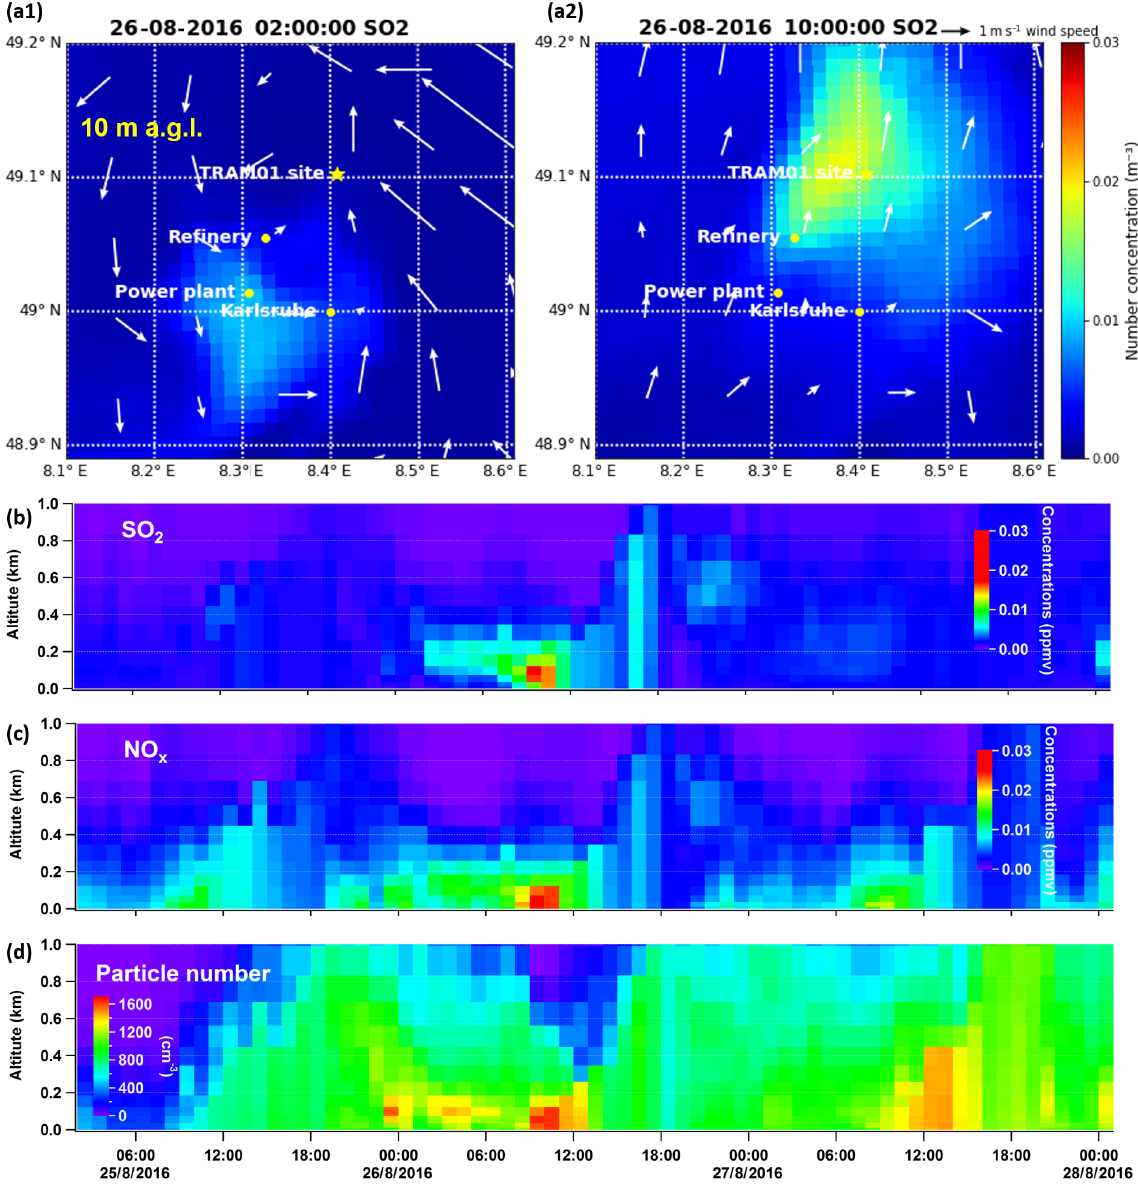
Figure 5. Modelled SO 2 concentrations at 02:00CEST (a1) and 10:00CEST (a2) on 26 August at 10ma.g.l. Panels (b) to (d) are time series of vertical profiles above the measurement site for simulated SO 2 , NO x , and total particle